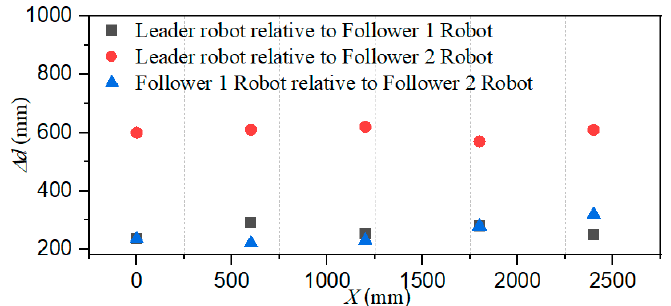
Figure 18. Relative localization offset with a longitudinal queue ( ∆ d is the relative distance between two robots).